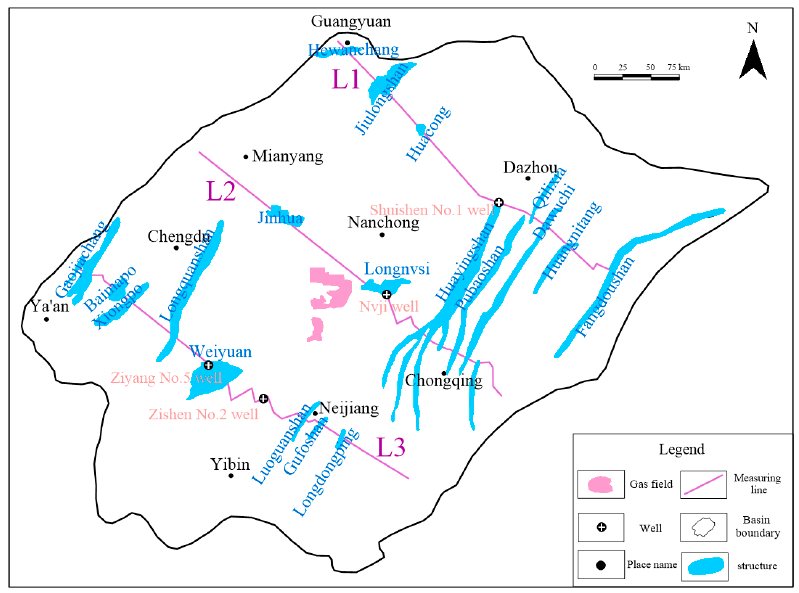
Figure 4. Large seismic profile location map of Sichuan Basin (modified from Li [2]).